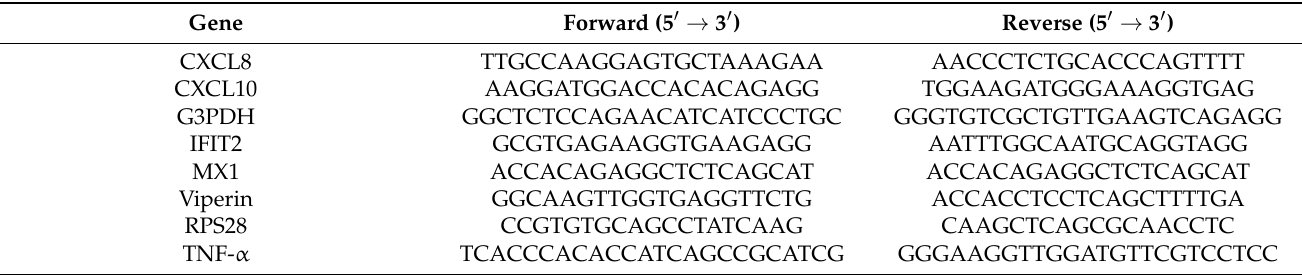
Table 1. Sequences of primers used for